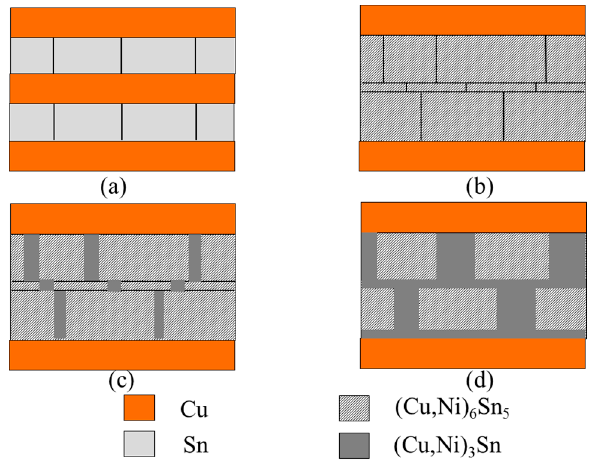
Figure 8. Schematic of the stage of growth of IMCs after long reflow at 300 °C for 60